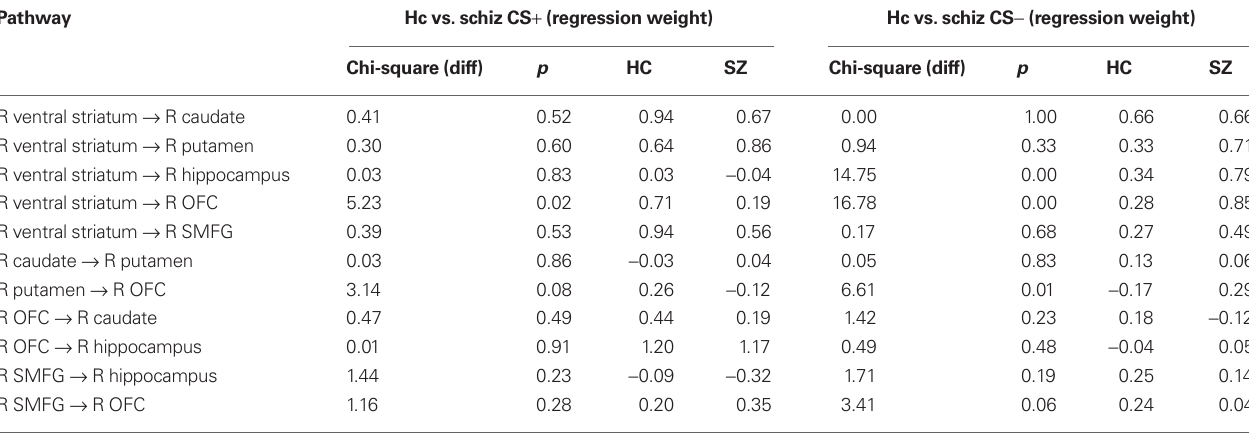
Table 5 | Path coefficients, χ DIFF2 and p values for group comparisons (hierarchical models approach) for healthy controls and schizophrenic patients in CS + and CS − conditions. Pathway